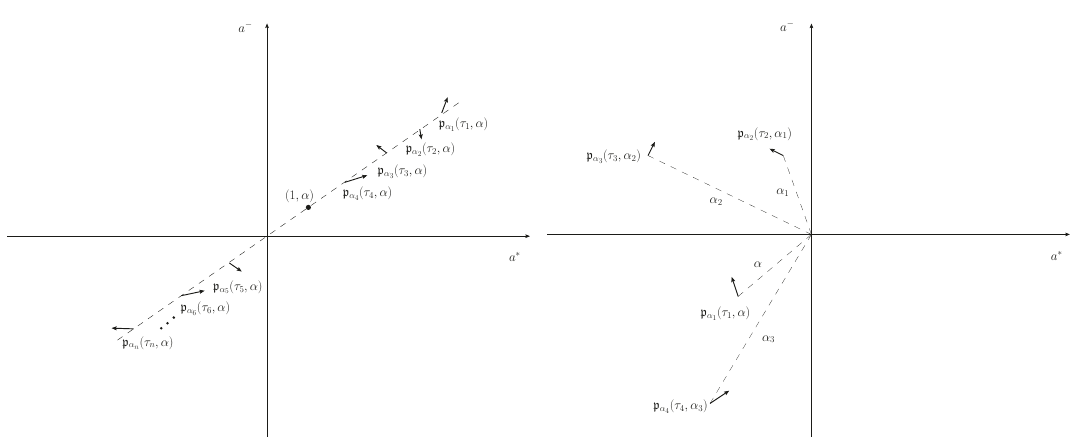
Figure 2 . Left: representation of the object ℓ ( n ) α . The vectors p α Right: representation of the object L ( n ) α . The vectors p α piecewise path which is determined as follows: the position of the following vector depends on the direction of the preceding vector. Thus, for example, the ray given by α is positioned is parallel to the direction of the vector p α